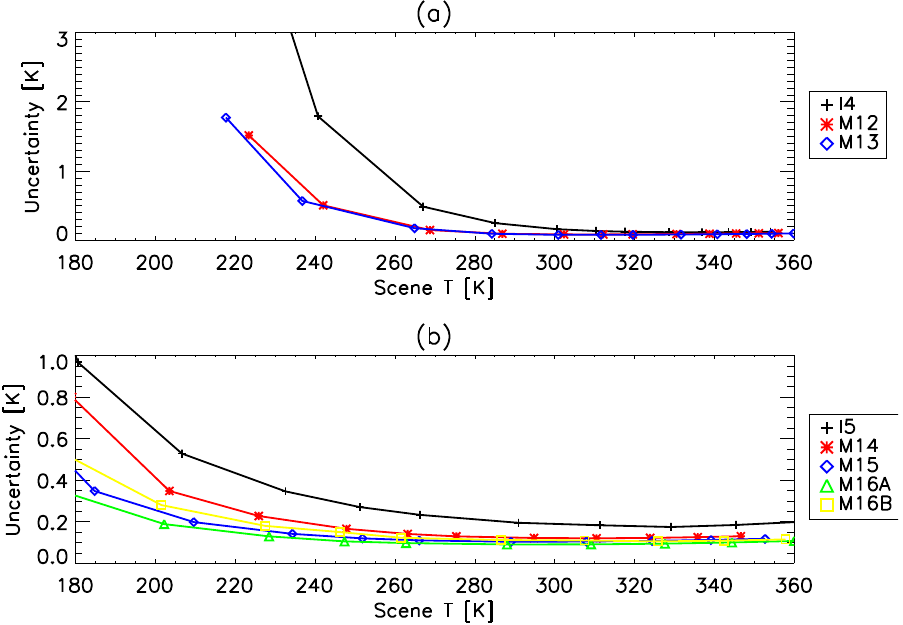
Figure 6. Plots show the modeled total temperature uncertainty as a function of scene temperature for the MWIR bands ( a ) and for the LWIR bands ( b ).